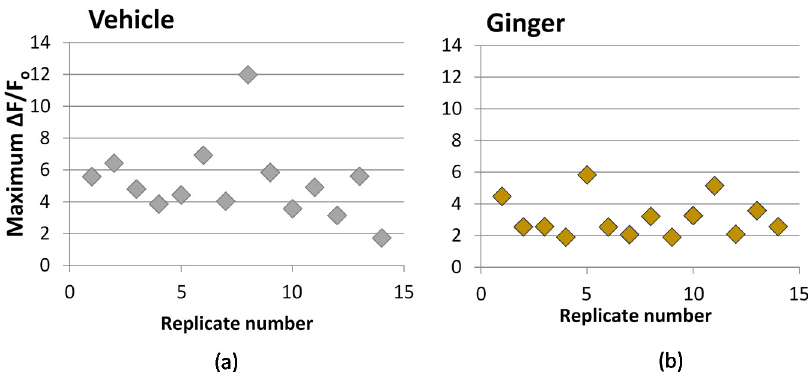
Figure 4. Calcium influx following treatment with methanol ginger extract. PC ‐ 12 cells transfected with GCaMP5 fluorescent calcium indicator were pre-treated for 10 min with ( a ) 0.1% DMSO vehicle or ( b ) 0.2 mg equiv/mL ginger extract. Maximum change in fluorescence compared to background ( ∆ F/F o ) when stimulated with 50 mM KCl is reported. All treatments contain 0.1% DMSO in media, including vehicle. ( P = 0.007, n = 14).